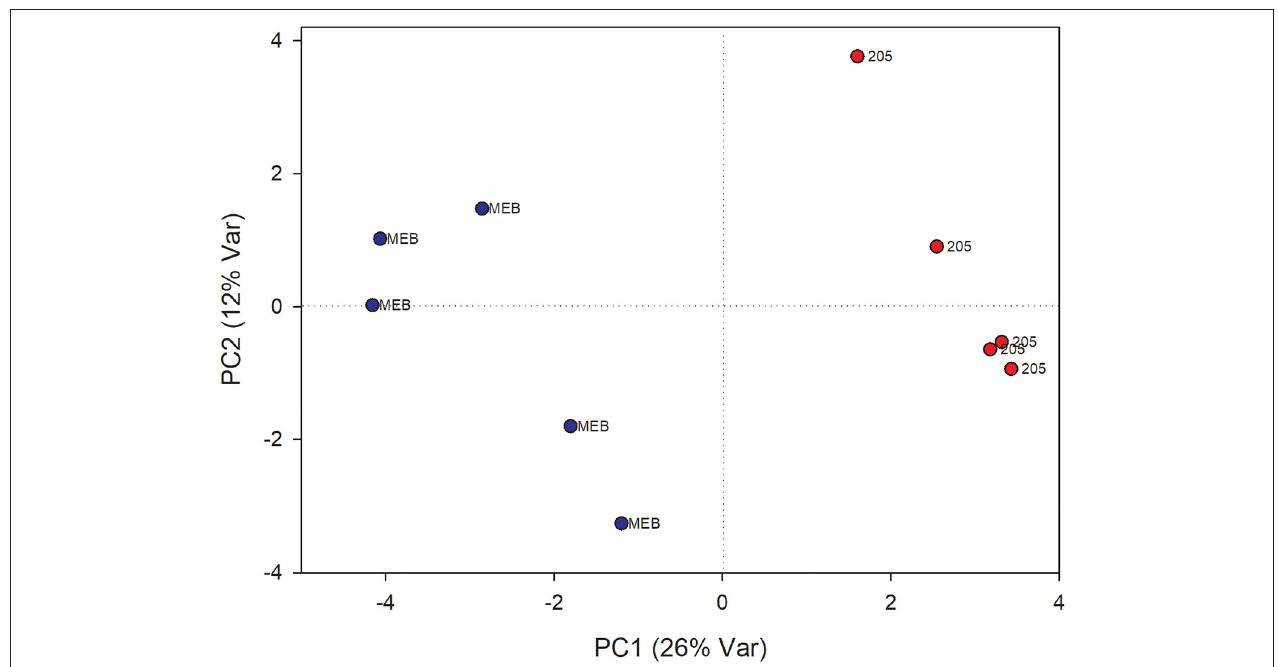
FIGURE 4 | PLS-DA score plot of NMR metabolomics data of chicory roots extracts of MEB (control) and C. globosum (205) groups. Blue dots indicate MEB (control) group and red dots indicate C. globosum group.